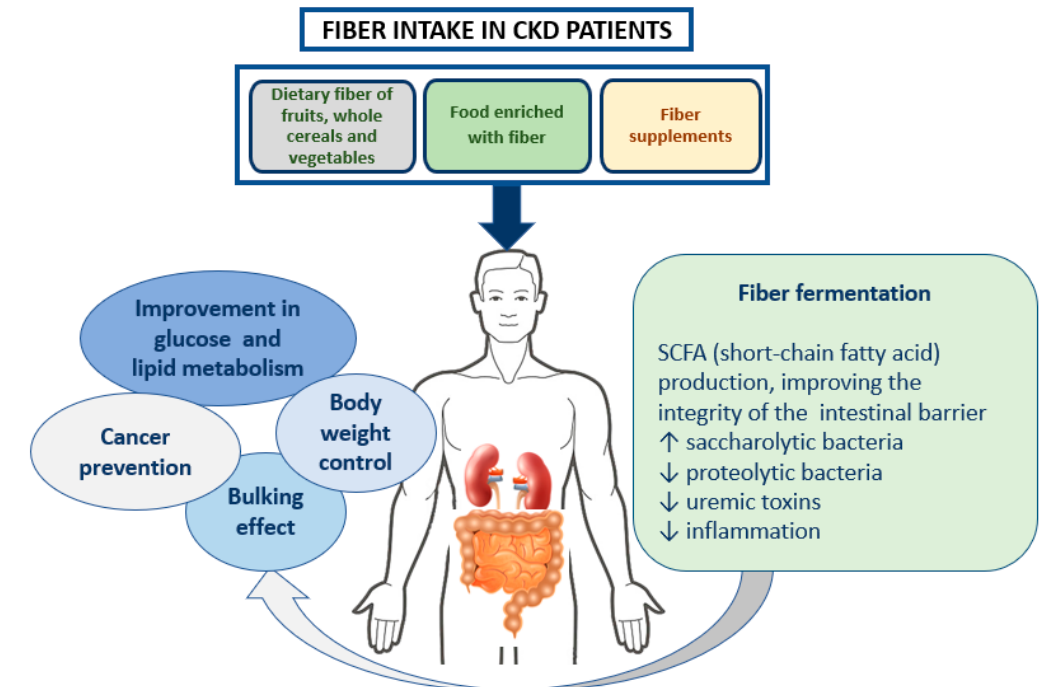
Figure 1. Potential beneficial effects of fiber in renal health. Fiber intake and fermentation are of crucial importance in the kidney-intestine axis, both for kidney health and for outcomes associated with other relevant conditions, such as cancer, diabetes, obesity (for references, see text). CKD: chronic kidney disease.